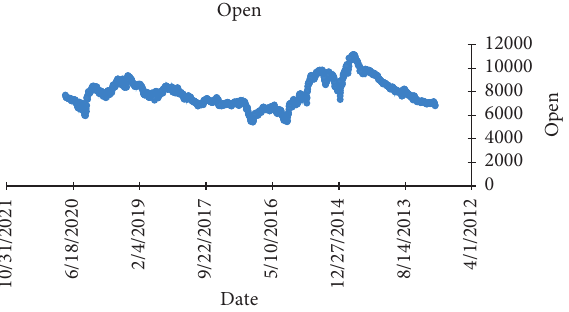
Figure 1: The series for the daily closing price index over the period of 1/1/2013 to 16/8/2020. Table 1: The descriptive statistics for the daily closing price index over the period of 1/1/2013 to 16/8/2020. Summary statistics